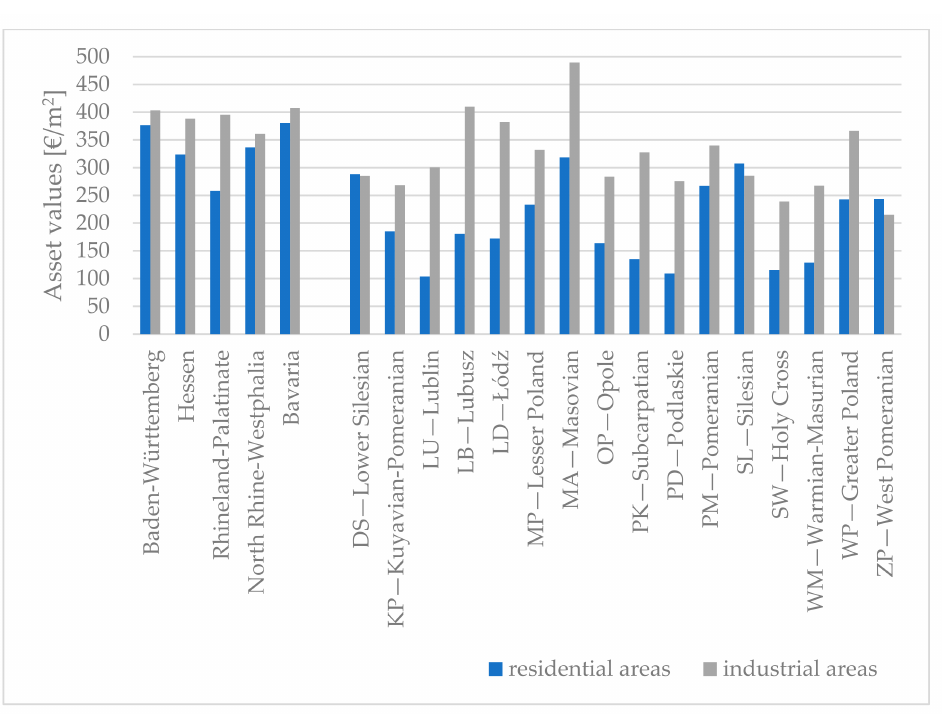
Figure 6. Comparison of asset values determined for Polish voivodships and German federal states, in 2019